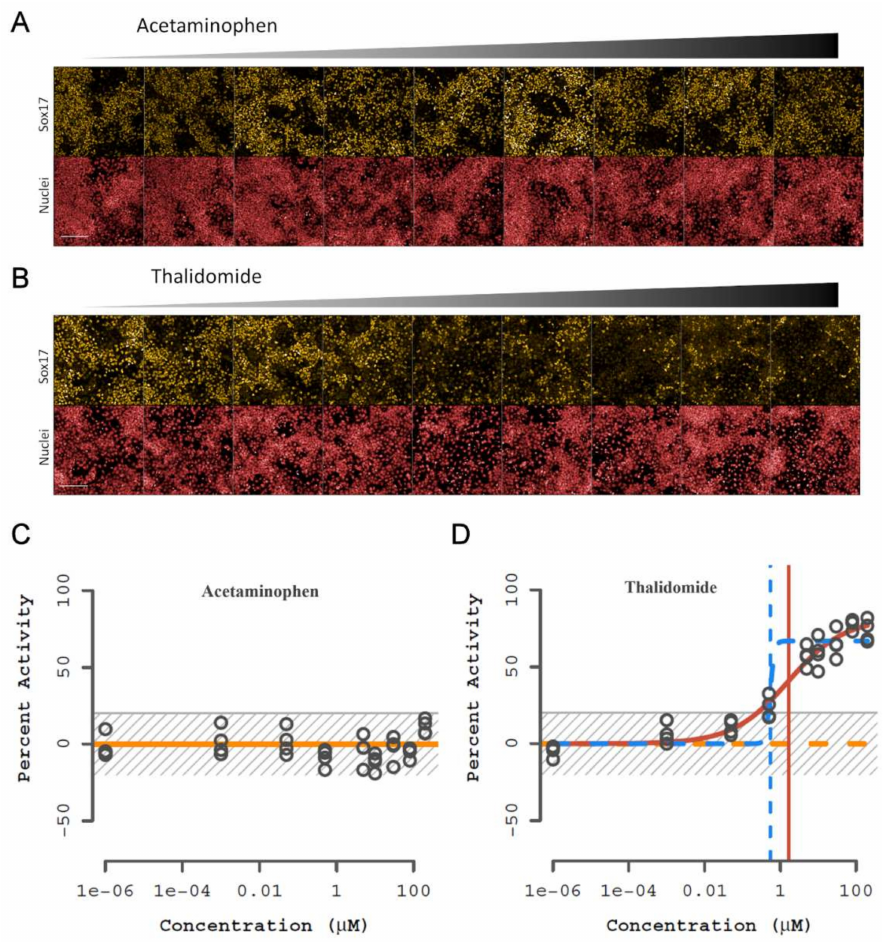
Figure 4. Representative images and curve fit plots from the chemical training set. Representative non-developmental toxicant (acetaminophen) and developmental toxicant (thalidomide) results. ( A , B ) Fluorescent images of SOX17 (yellow) expression and nuclei (red) with increasing concentration of chemical. RUES2-GLR cells were exposed to chemical during endoderm differentiation for 48 h; 1 mm scale bar. ( C , D ) Percentage activity relative to control for SOX17-positive cells. Horizonal lines represent different curve fits with winning model in solid and vertical lines indicate concentration at 50% activity; yellow—constant, orange—Hill, blue—gain-loss. The gray striped box is the baseline and noise band (0 ± 3*bmad); ( n =